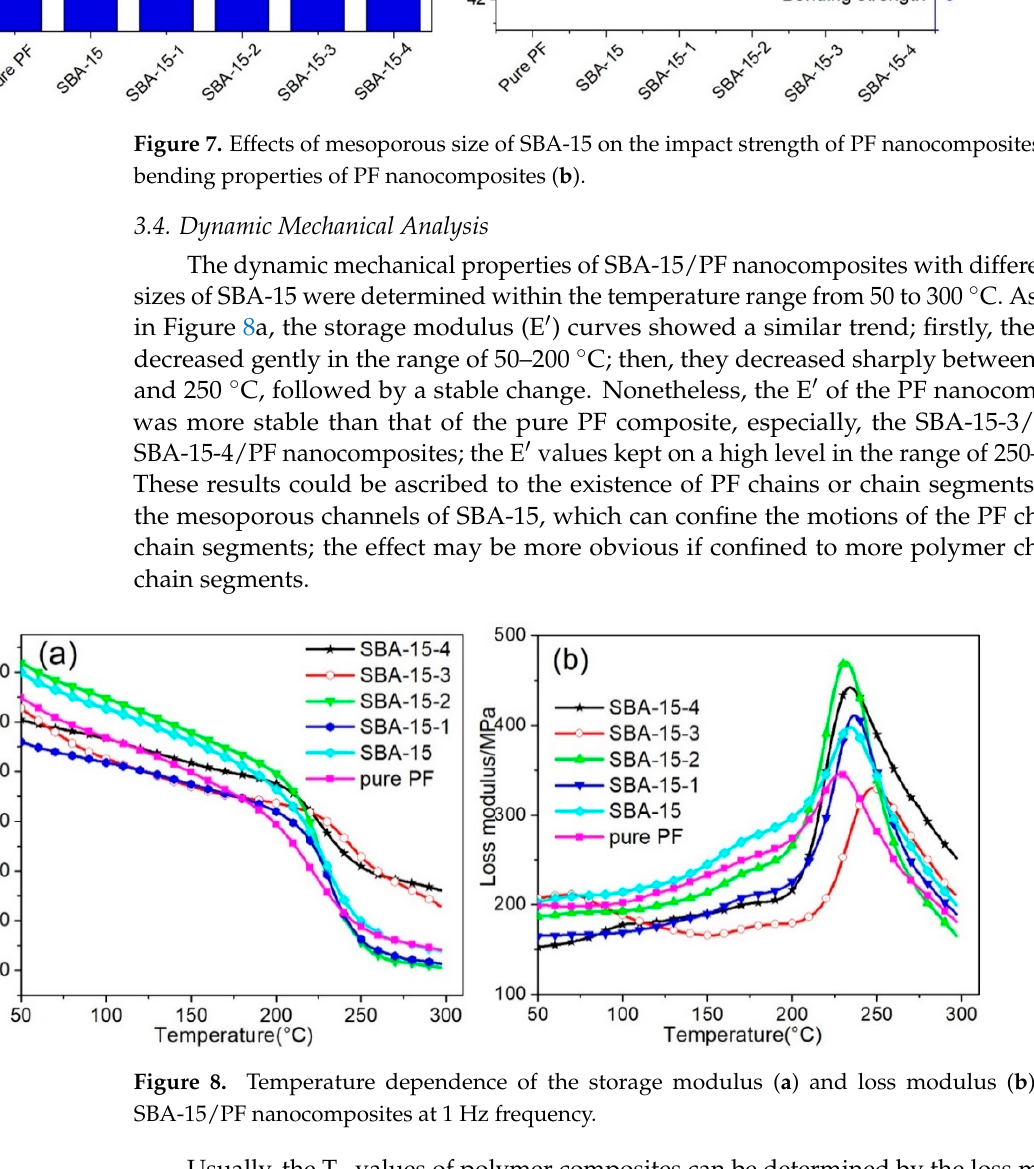
15/PF nanocomposites at 1 Hz frequency.